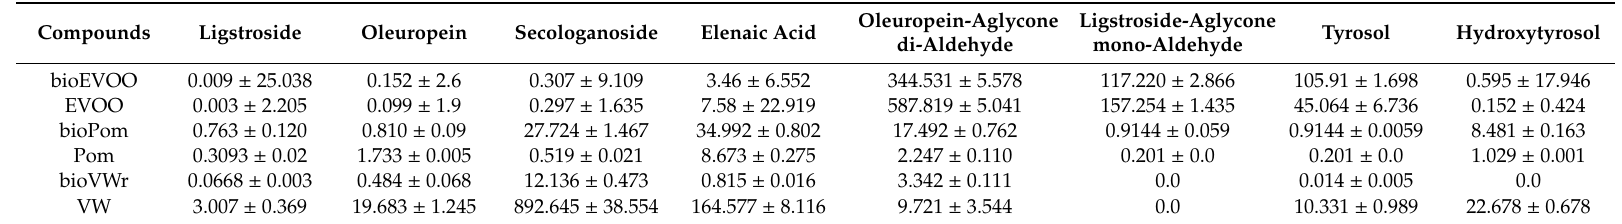
Table 5. Secoiridoid compounds and their degradation product concentrations (mg / kg).